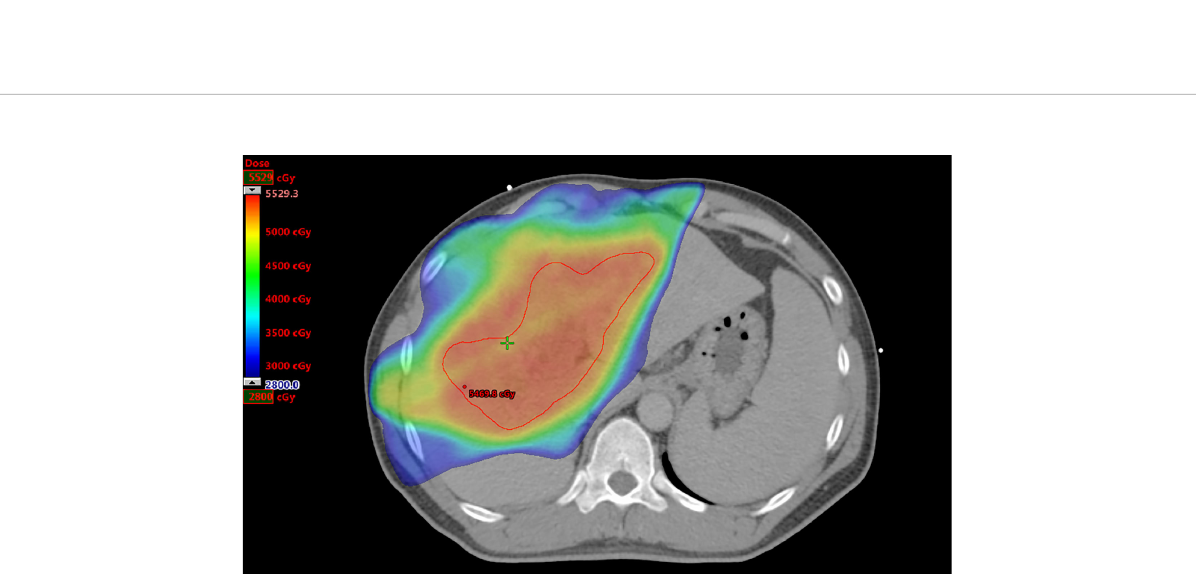
FIGURE 2 Radiation therapy plan for a patient. The prescribed dose to treat portal vein tumor thrombosis only is 50 Gy. The clinical target volume as the region of interest is contoured in red, and the volume is 280.7 cm 3 . The normal liver volume is 1,769.0 cm 3 , and the mean liver dose is 2,189.4 cGy.